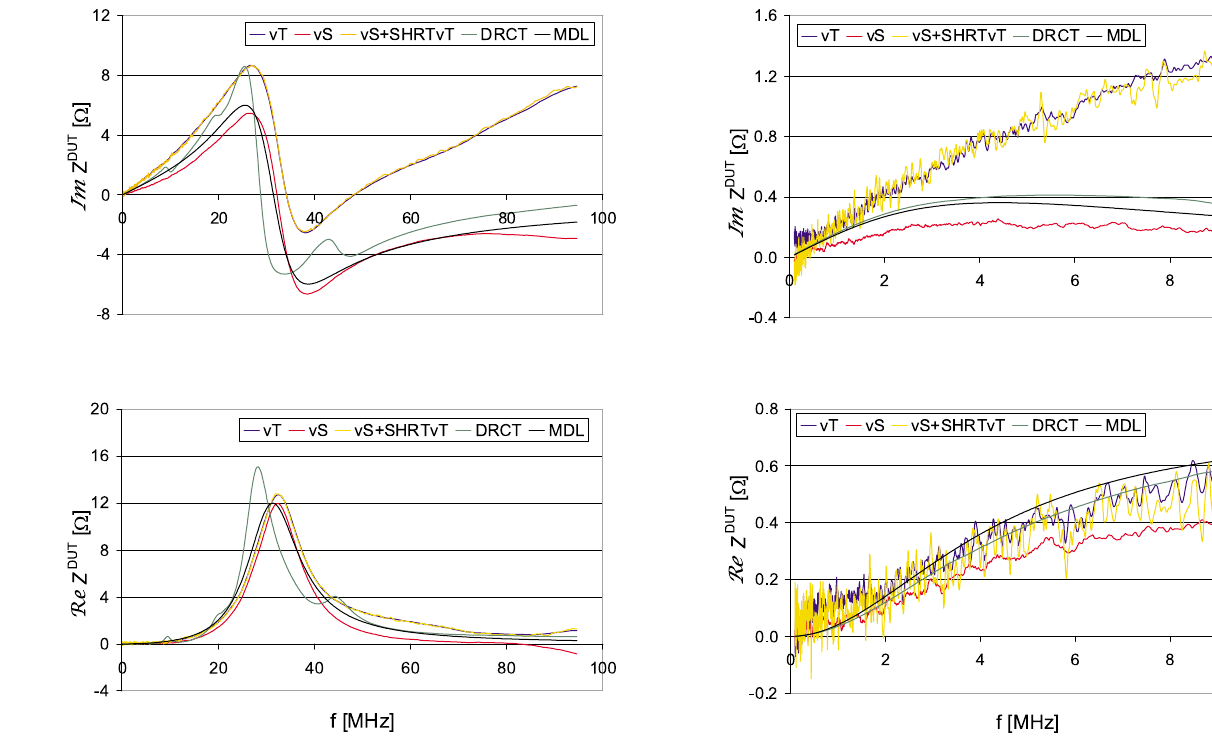
FIG. 13. (Color) DUT impedance of terminated magnet at low frequencies.